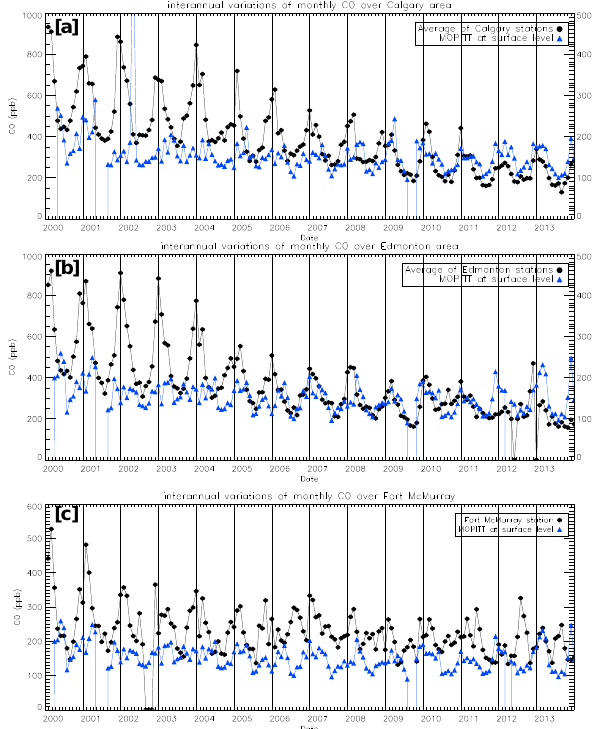
Figure 10. CASA CO in situ measurements (left axis) and MOPITT CO at surface level (right axis) at (a) Calgary, (b) Edmonton, and (c) Athabasca